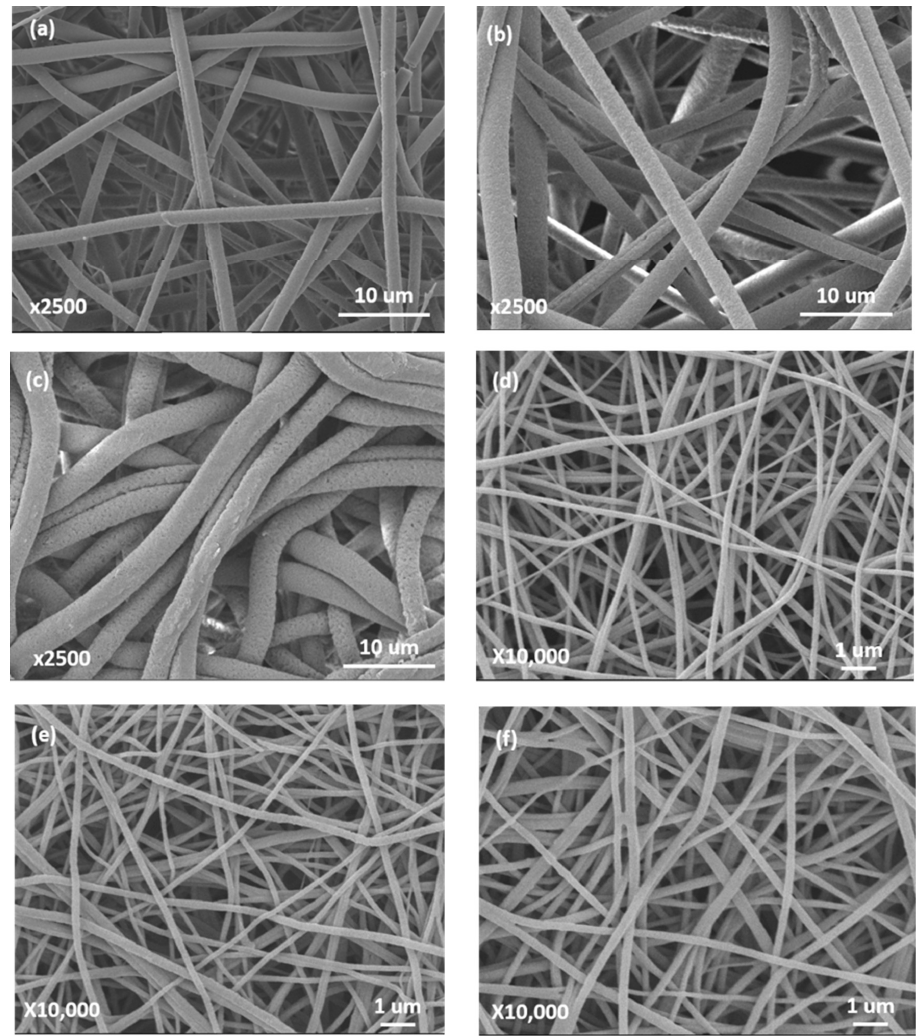
Figure 3. SEM morphology of unmodified PSf ( a ), PSf-GMA with 7 min UV ( b ), PSF-GMA-DEA ( c ), unmodified mPAN ( d ), mPAN-GMA with 15 min UV ( e ), and mPAN-GMA-DEA ( f ). unmodified mPAN ( d ), mPAN-GMA with 15 min UV ( e ), and mPAN-GMA-DEA ( f